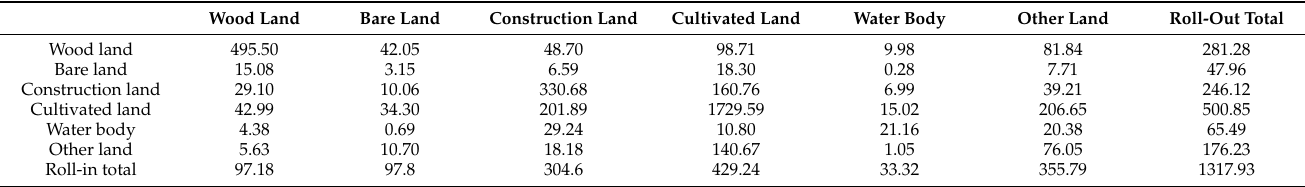
Table 5. Land use transfer matrix of Jiaozuo City from 1993 to 2003 (km 2 ).